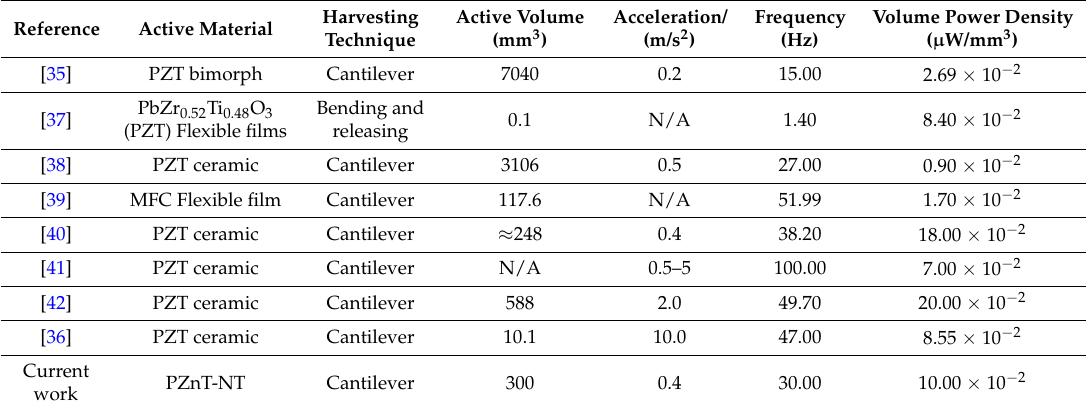
Table 2. Comparison of the volume power density based on low acceleration and frequency. N/A: Not